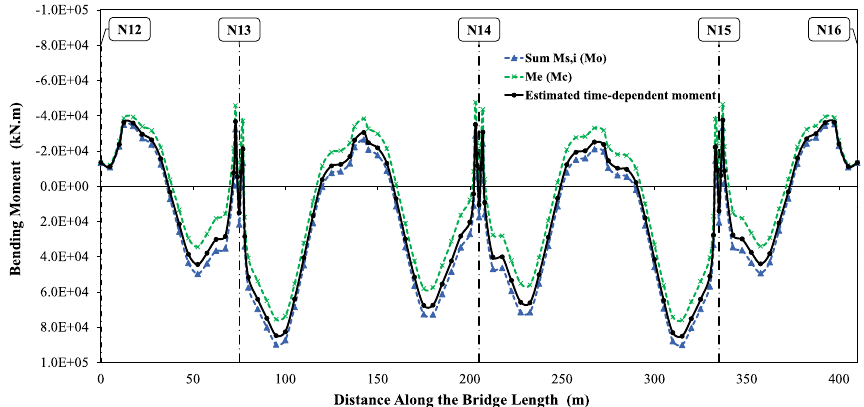
Fig. 15 Estimated time-dependent moments along Girga Bridge using the simplified approach per Kwak and Son